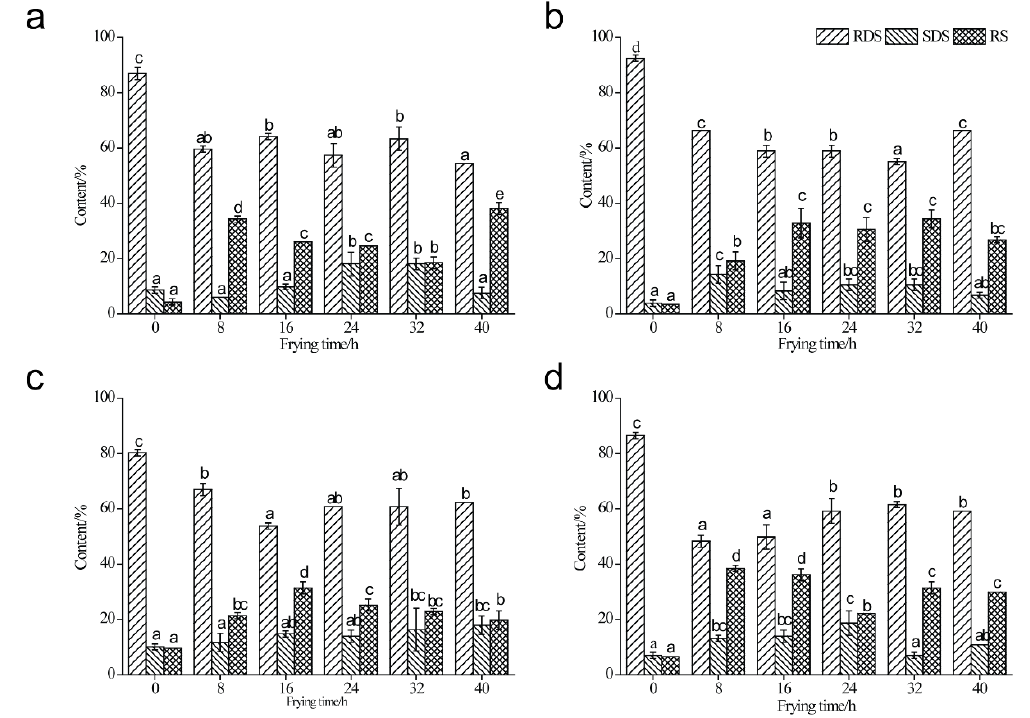
Figure 3. In vitro digestibility of native maize starch, potato starch, high-amylose maize starch, and wheat starch (0 h), as well as those during the deep-frying process (8 h, 16 h, 24 h, 32 h, 40 h). ( a ) Maize starch; ( b ) Potato starch; ( c ) High-amylose maize starch; ( d ) Wheat starch.